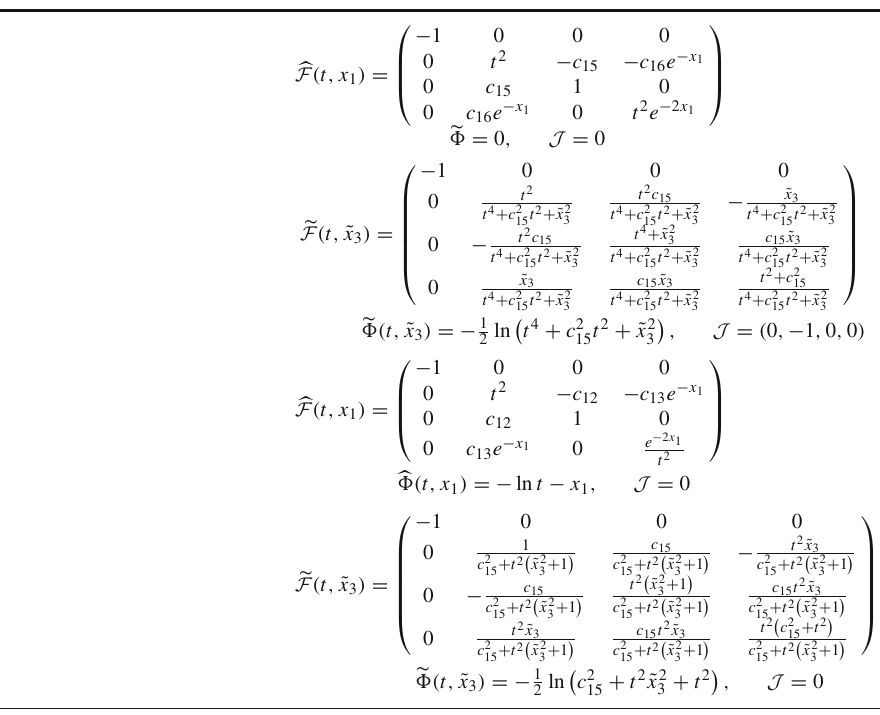
Table 4 Results for Poisson–Lie identities and dualities of Bianchi V cosmology and dilaton (cid:14) = 0